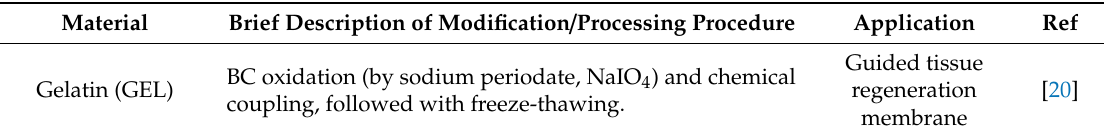
Table 1. Material use in BC-based nanocomposites, the modification route and biomedical application. Material BC oxidation (by sodium periodate, NaIO 4 ) and chemical coupling, followed with